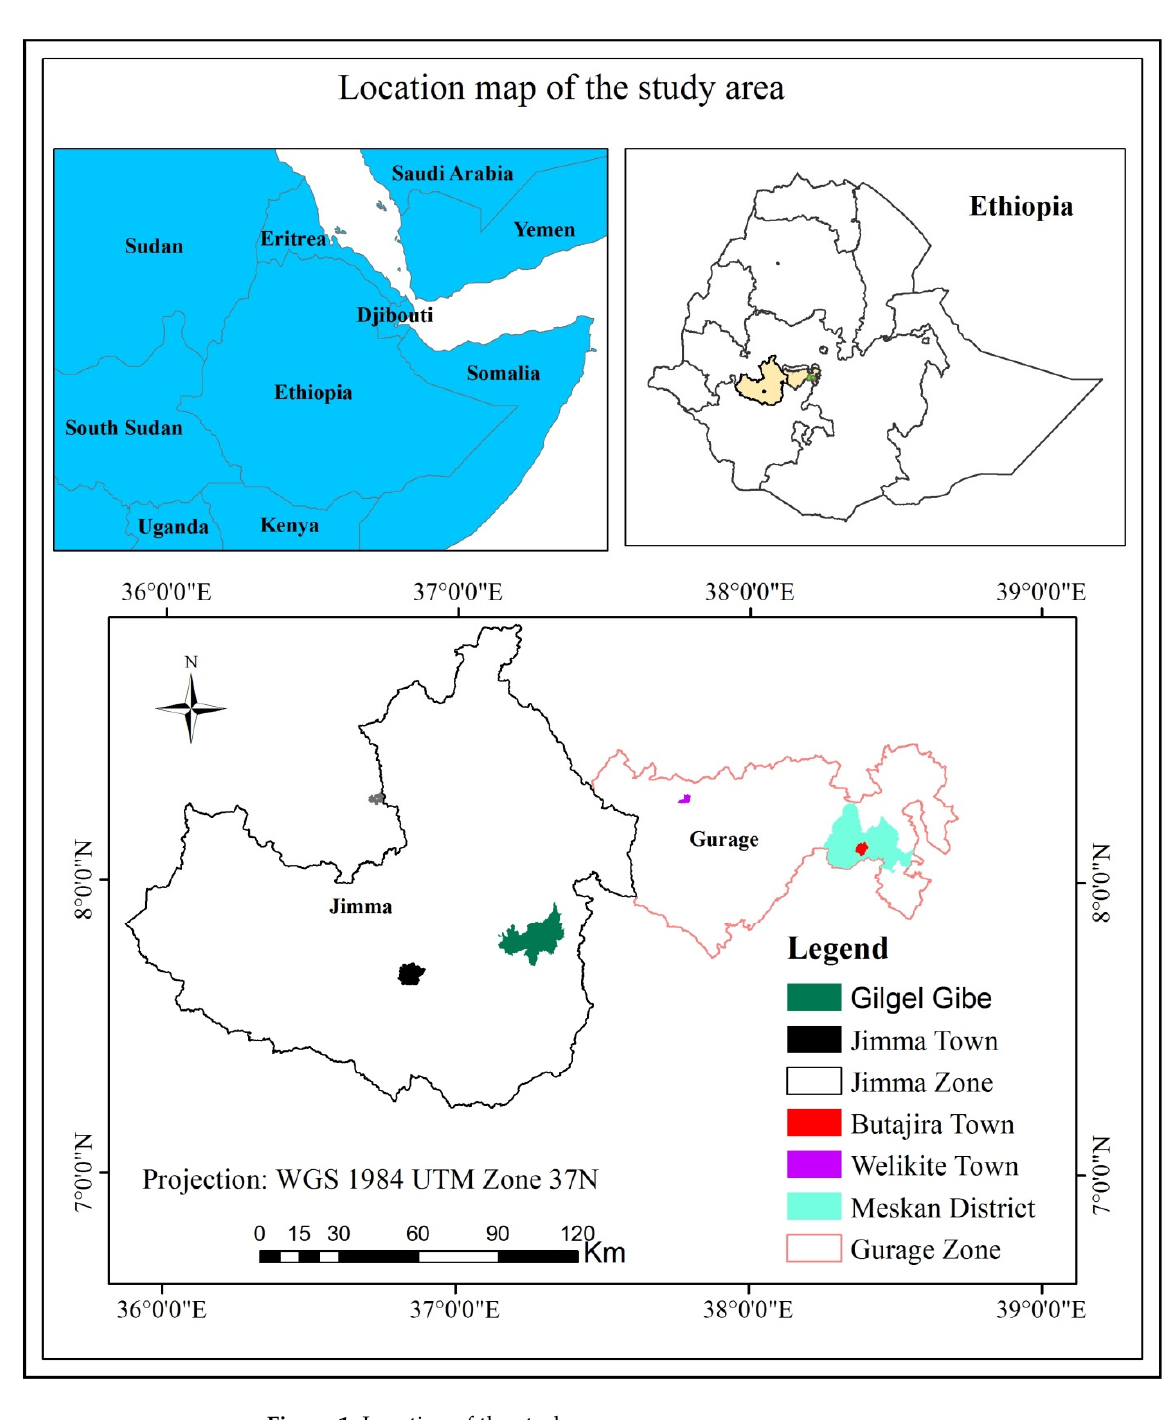
Figure 1. Location of the study